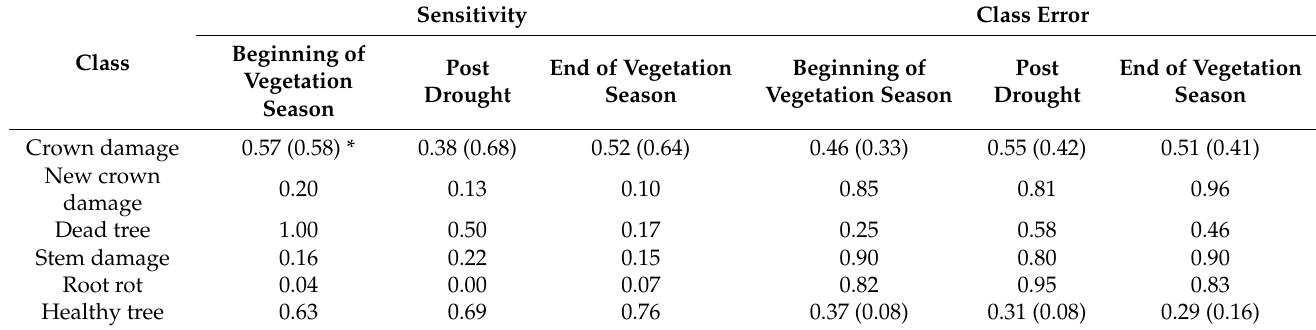
Table 7. Sensitivity and class errors for RF classifier. * the sensitivity and class errors are shown in brackets when two classes (Crown damage and Healthy tree class) were used in the RF